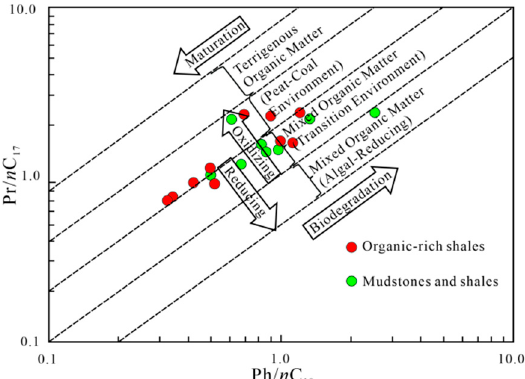
Figure 9. Cross-plot of Pr/nC 17 vs. Ph/nC 18 ratios for source rock samples from LS2 of the Weixinan Sag, Beibuwan Basin (modi fi ed from Ref. [23]).